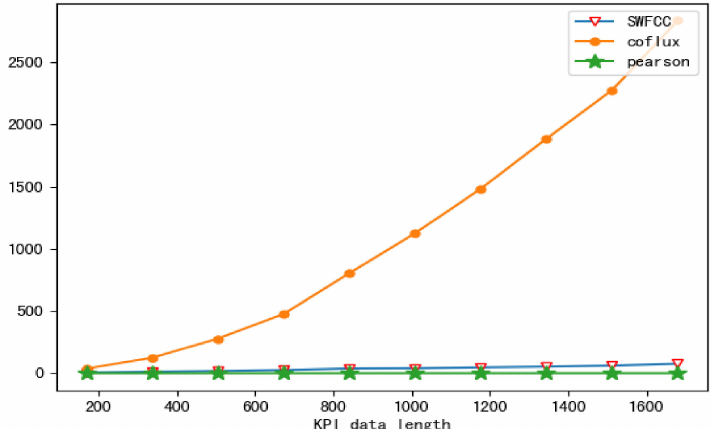
Figure 7. Calculation time of three of the methods under different KPI lengths. In the figure, the calculation speed of the SWFCC method proposed in this paper is close to that of Pearson, and the calculation speed of the Coflux method is